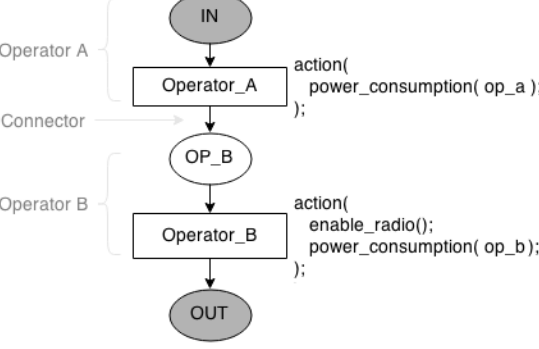
Figure 4. Generic Consumption Function Model.